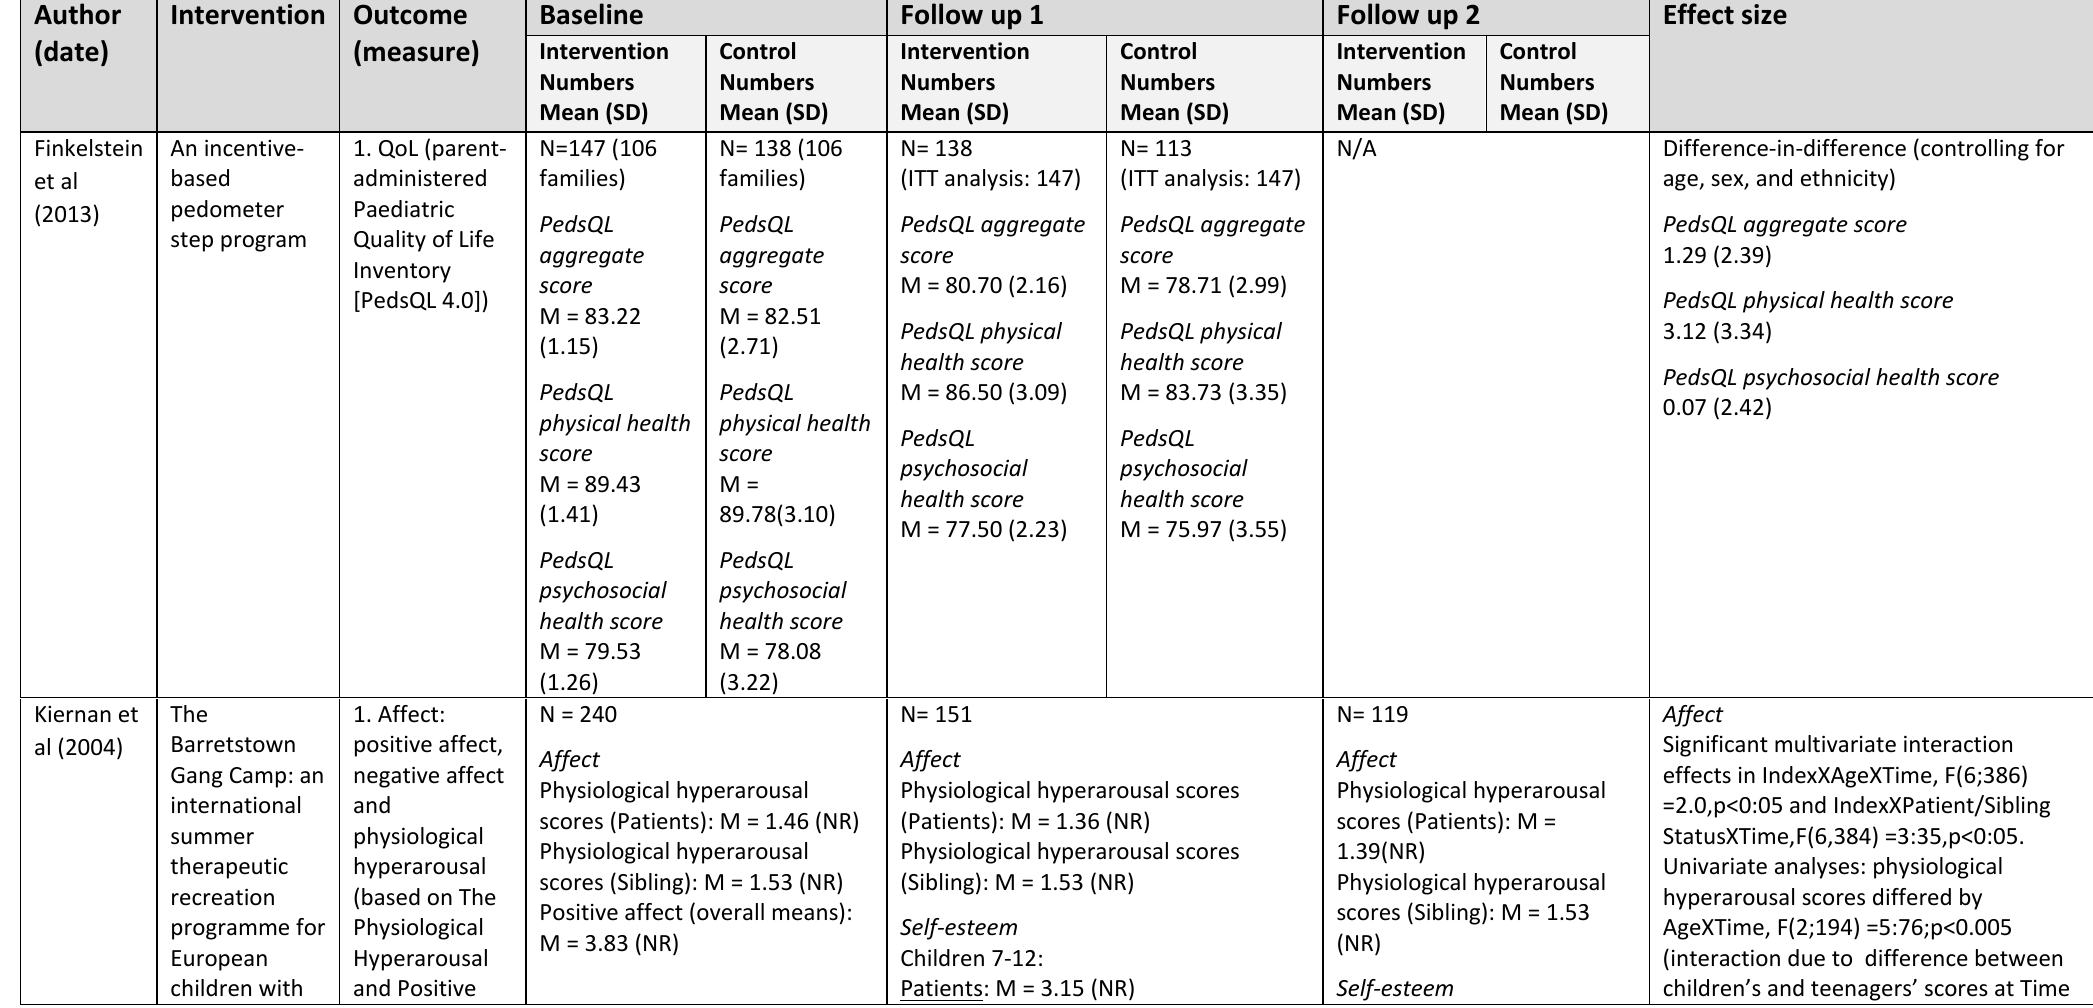
Table 5 Summary of numerical results (published